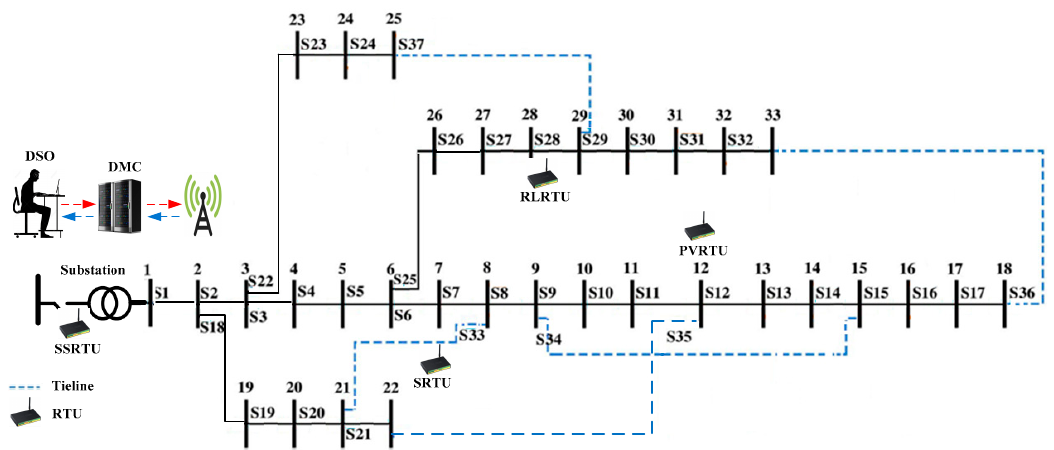
Figure 4. The IEEE 33-bus radial distribution test system.